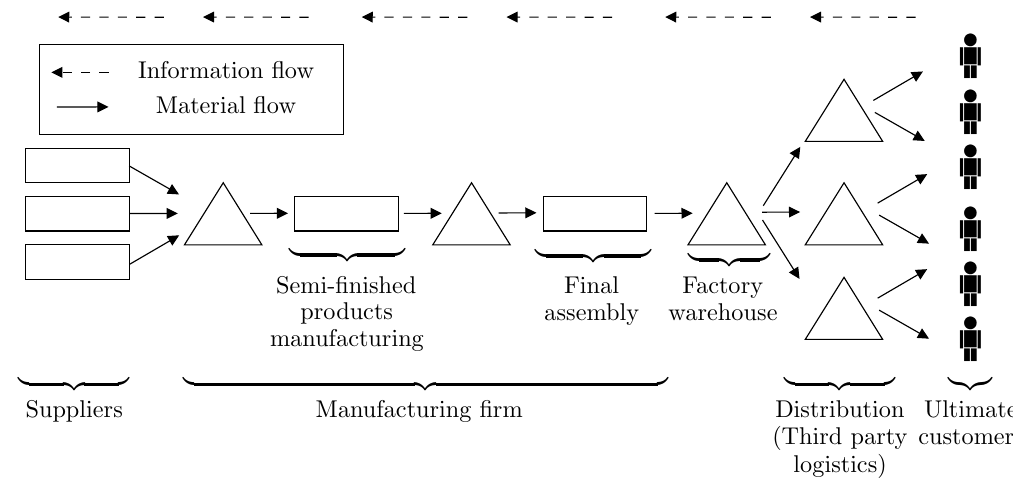
Figure 2: The main elements of a typical supply